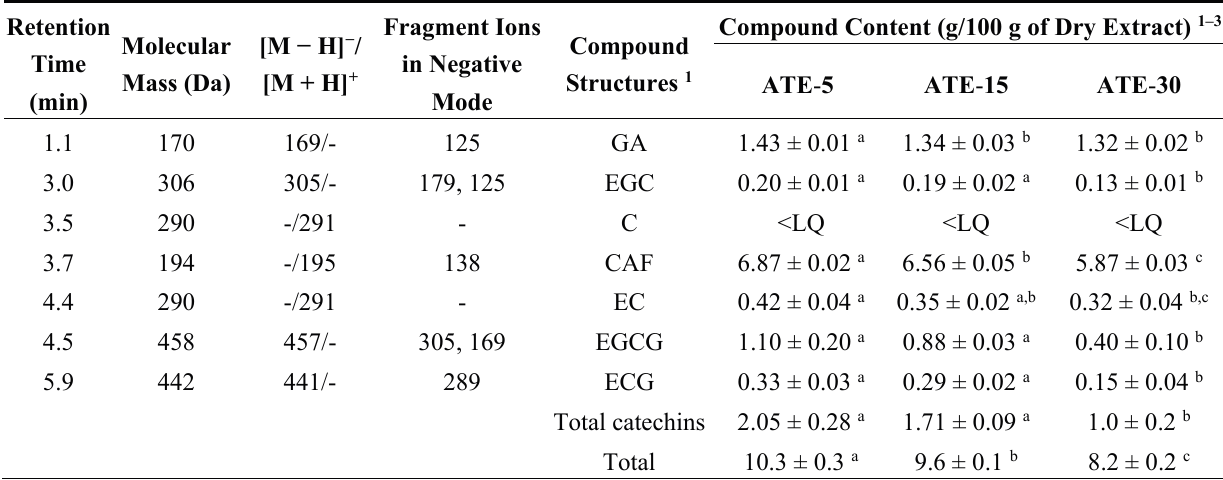
Table 2. ESI-MS/MS fragments of the compounds identified in the aqueous tea